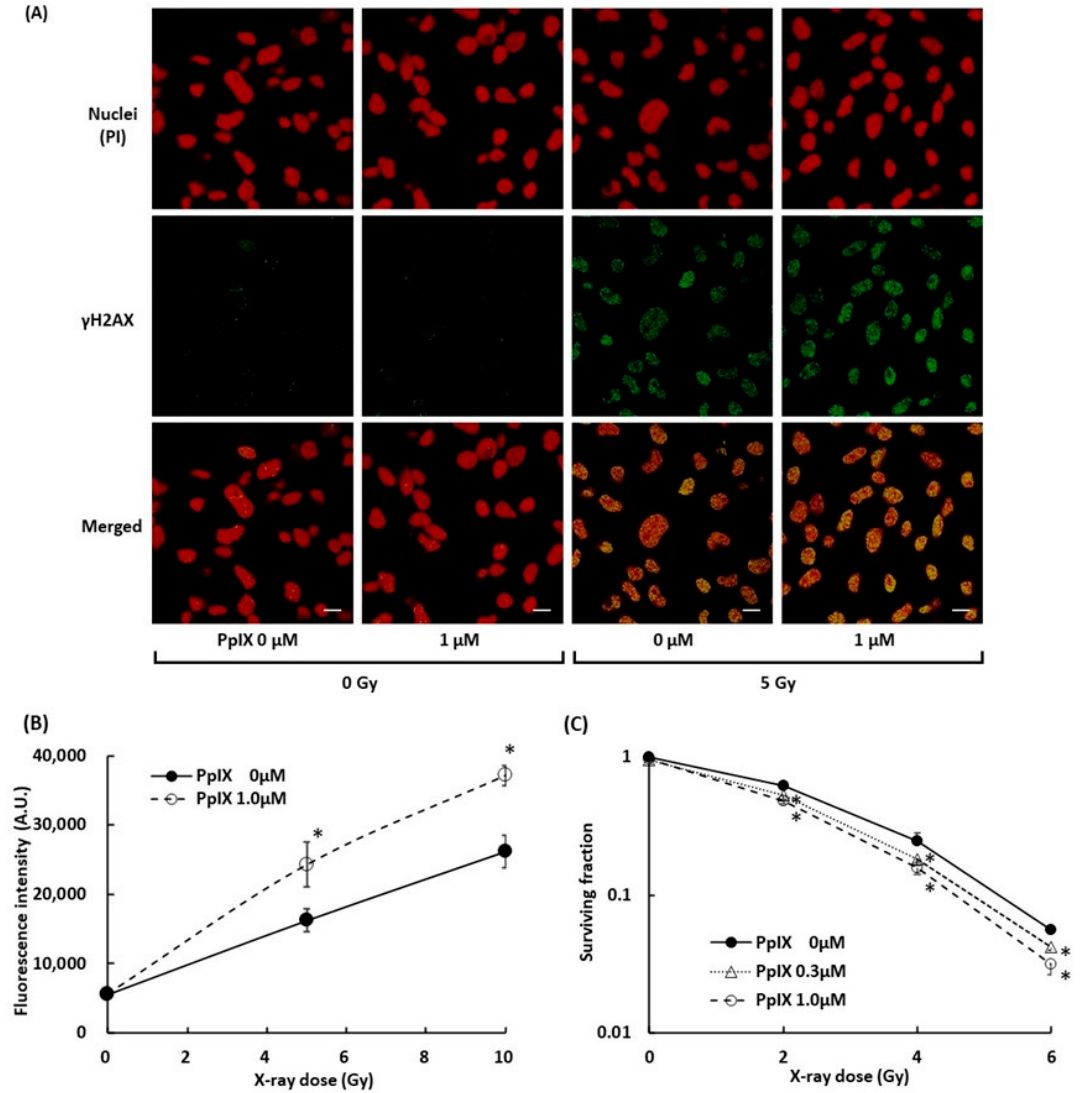
Figure 5. Evaluation of double-strand breaks (DSBs) within nuclei by X-ray irradiation and enhancement by PpIX. ( A ) Fluorescence in cell culture was imaged using laser confocal microscopy. Subcellular localization of γ H2AX (green) and propidium iodide (PI)-stained nuclei (red) in cells with and without exposure to 1 µ M PpIX or 5 Gy X-ray radiation. Scale bars: 20 µ m. ( B ) The fluorescence intensity of γ H2AX. ( C ) The WST-8 cell viability assay for cellular responses to PpIX treatment and X-ray irradiation. Data are the means ± SD ( n = 4). Statistical significance ( p < 0.01) relative to the experiment performed without PpIX at the same irradiation dose indicated by (*).